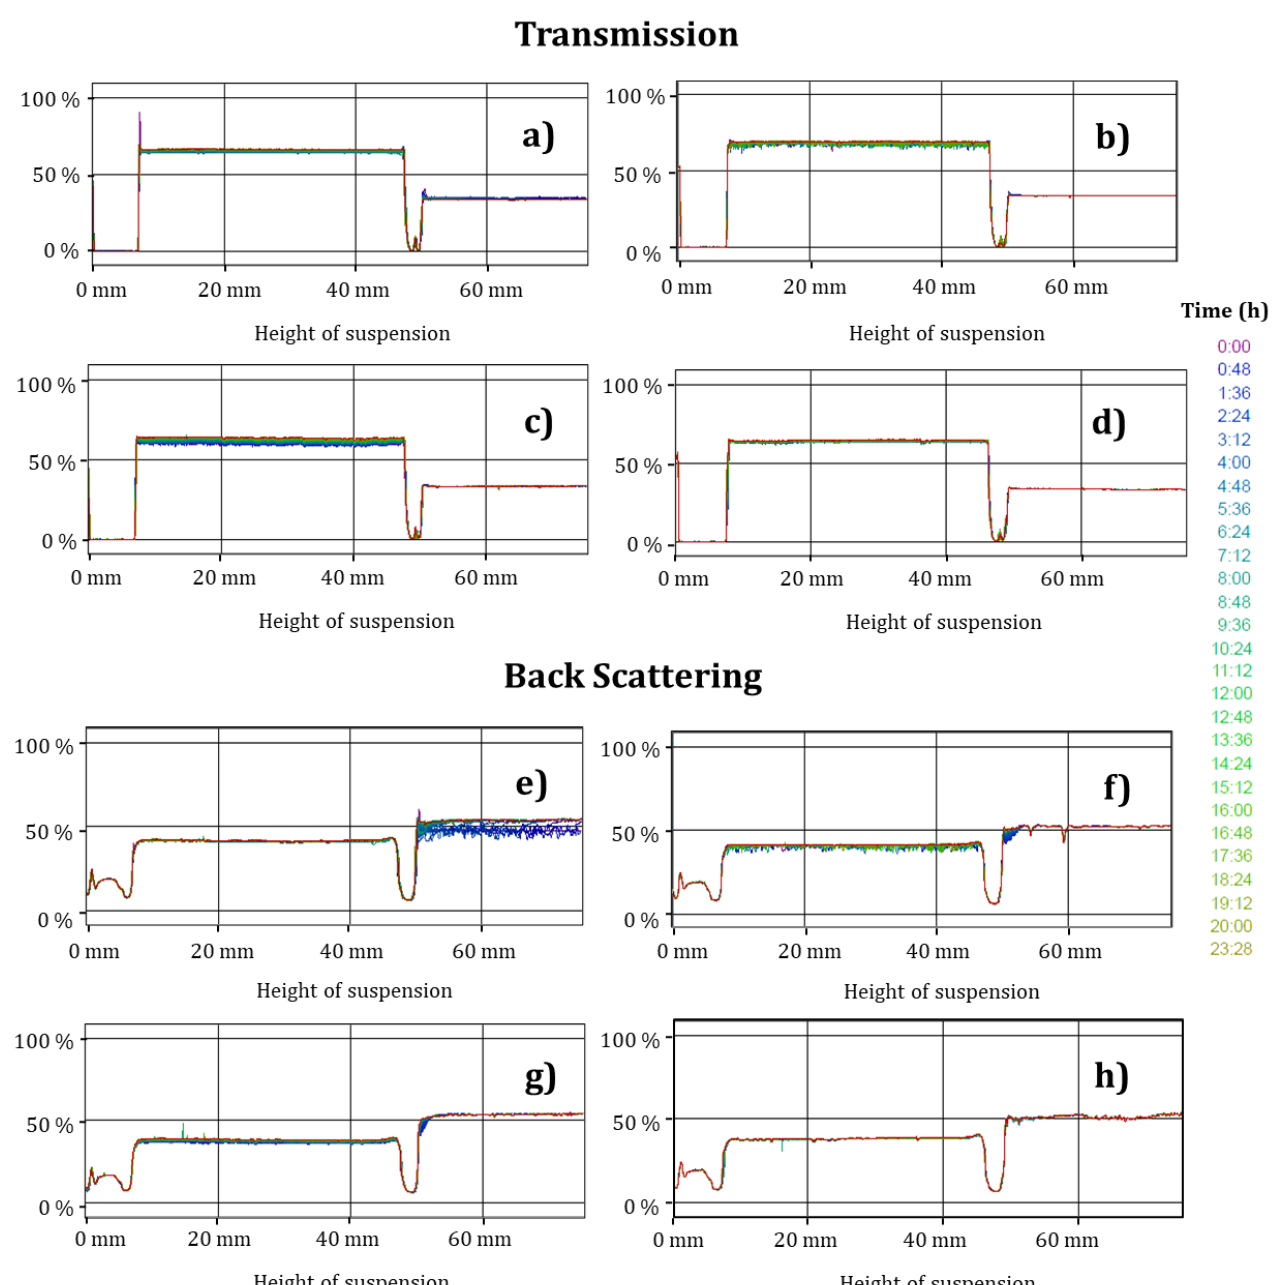
Figure 5. Transmission and backscatter profiles of nanocapsules stored at 25 °C. ( a ) and ( e ) initial, ( b ) and ( f ) week 1, ( c ) and ( g ) week 3 ( d ), and ( h ) week 5.